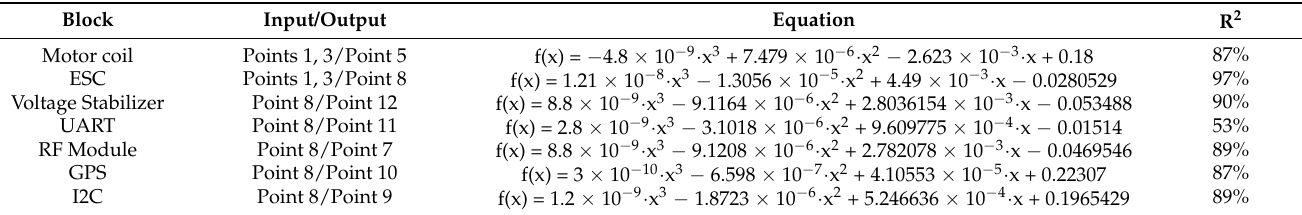
Table 1. Mathematical transmittance of selected